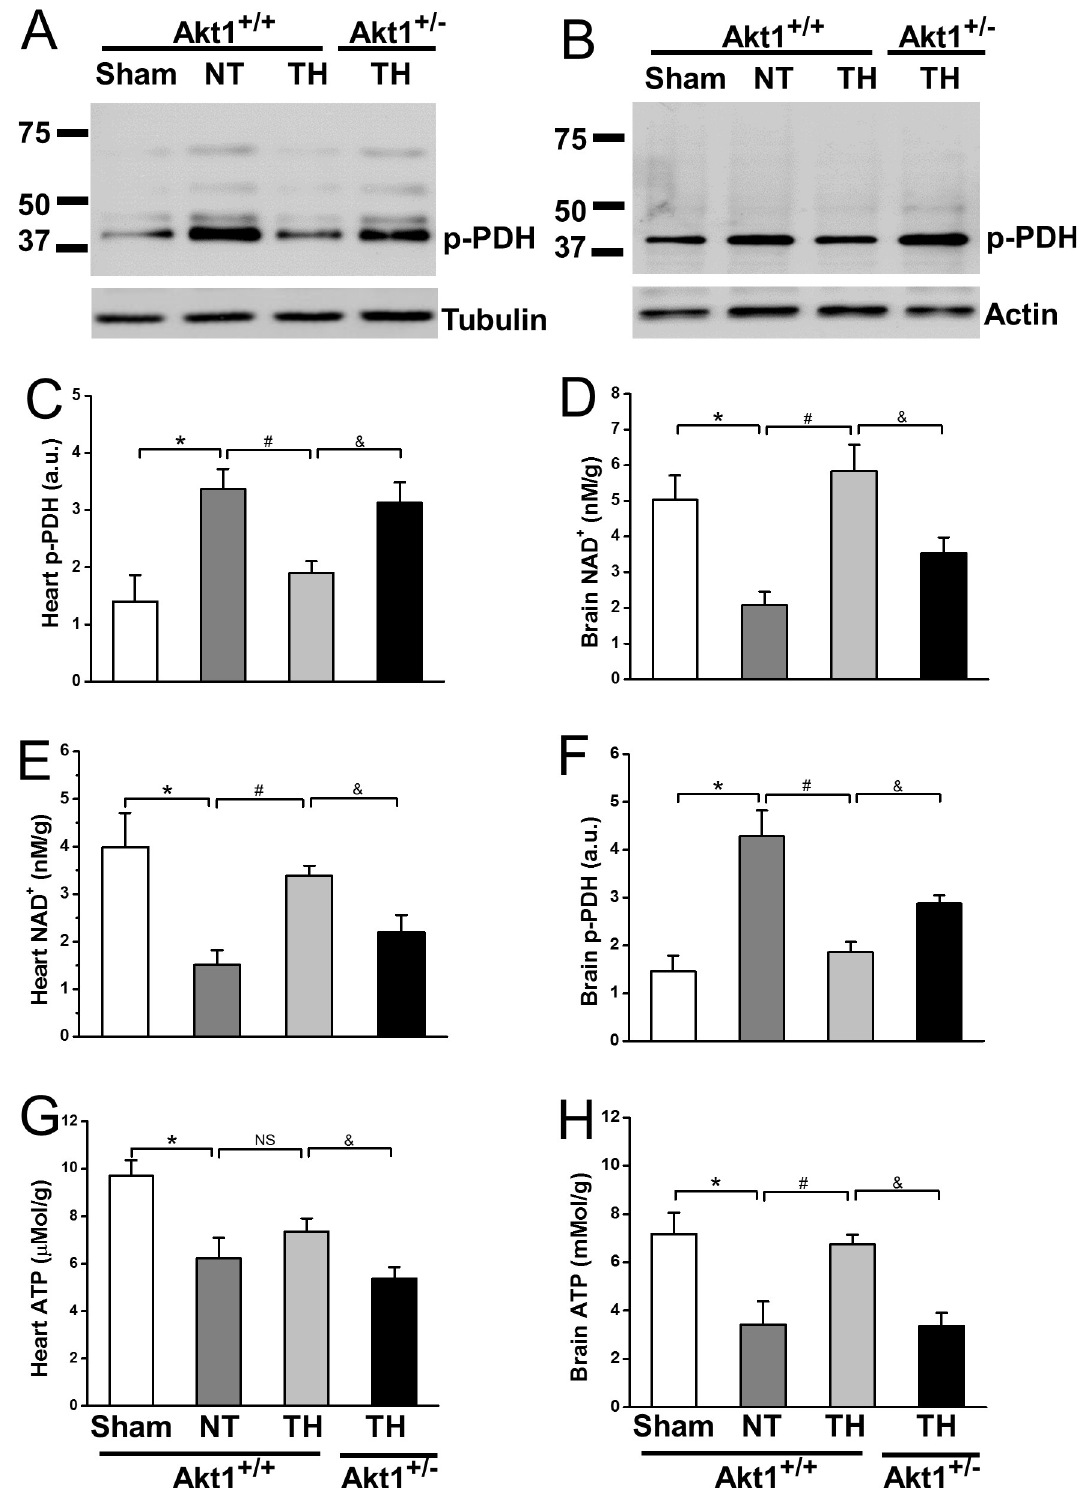
Fig 5. PDH Phosphorylation, and NAD and ATP contents were measured at R30 in heart (A, C, E, G) and brain (B, D, F, H) in Akt1+/+ and Akt1+/- mice treated with TH . A , C : PDH Phosphorylation at R30 in heart. α -tubulin was used as loading controls. B , D : PDH Phosphorylation at R30 in brain. β -actin was used as loading controls for brain. E : NAD + contents at R30 in heart. F : NAD +